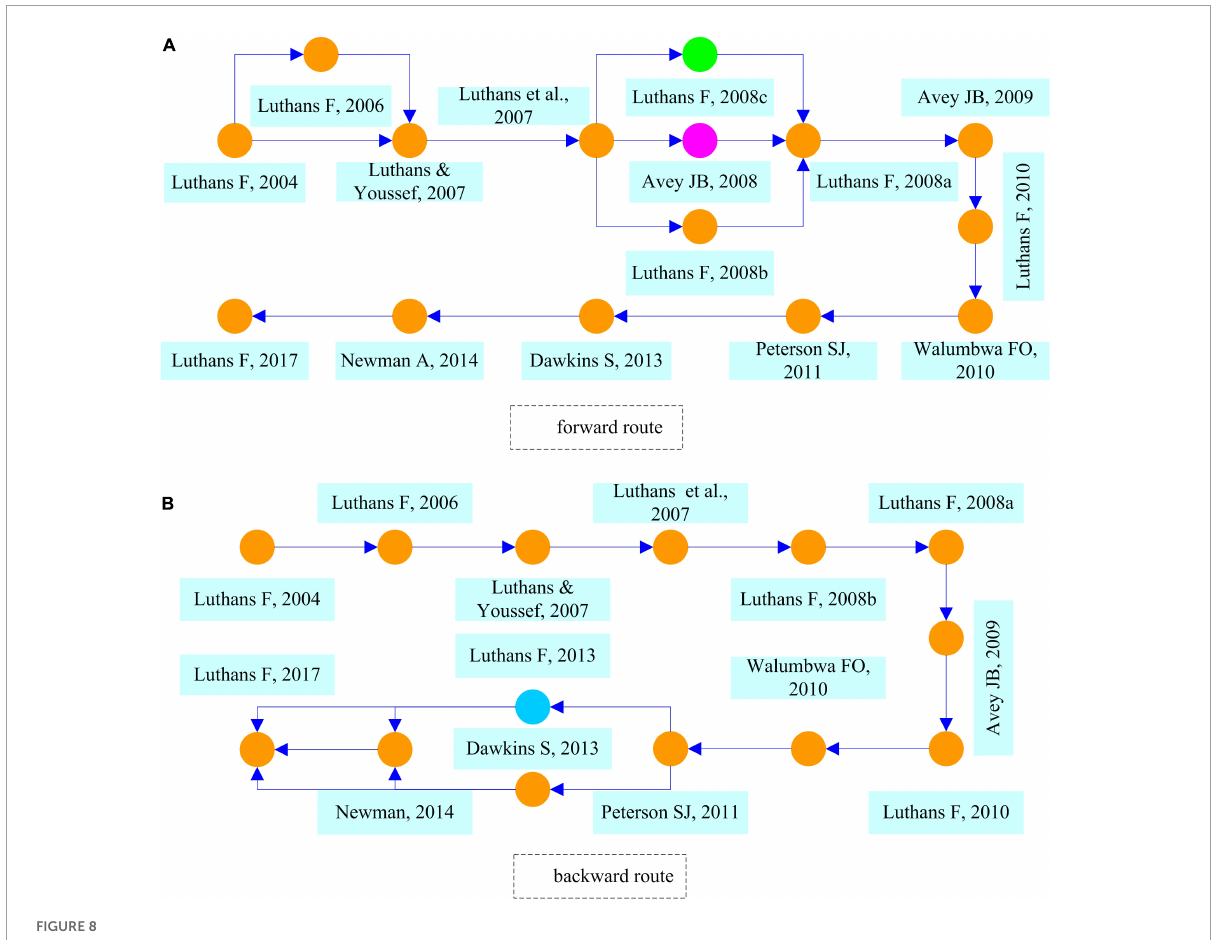
FIGURE8 Local forward route (A) and backward route (B) in the field of PsyCap.